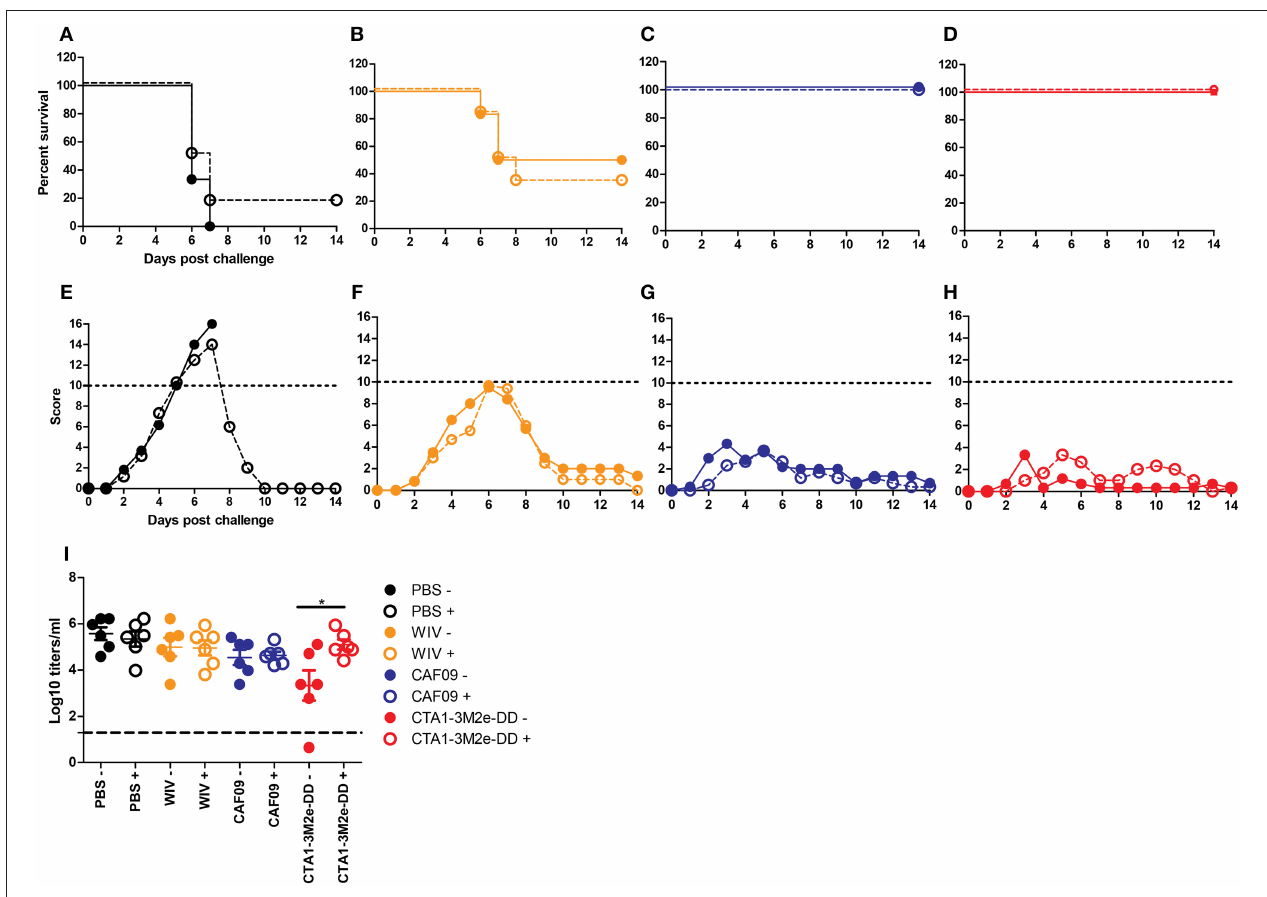
FIGURE 4 | CD4 depletion does not affect protection but affects virus growth. Mice ( n = 12/group) were vaccinated thrice i.n. with PBS (A,E) , non-adjuvanted WIV (B,F) , WIV + CAF09 (C,G) or WIV + CTA1-3M2e-DD (D,H) followed by heterosubtypic challenge. On day − 1, 1 and 7 relative to the challenge, anti-CD4 antibody or PBS was administered i.p.. Mice were followed for 14 days for survival (A–D) and clinical symptoms (E–H) . Dotted lines in E-H indicate the humane endpoint. Six animals/group were sacrificed on day 3 post challenge to determine lung virus titers (I) . LoD is indicated by dashed line. Mock depletion is presented by filled symbols with—and CD4 depletion is represented by open symbols with + . Virus titers are represented as log 10 titers /gram of lung with level of significance as * p < 0.05 calculated using Mann-Whitney U